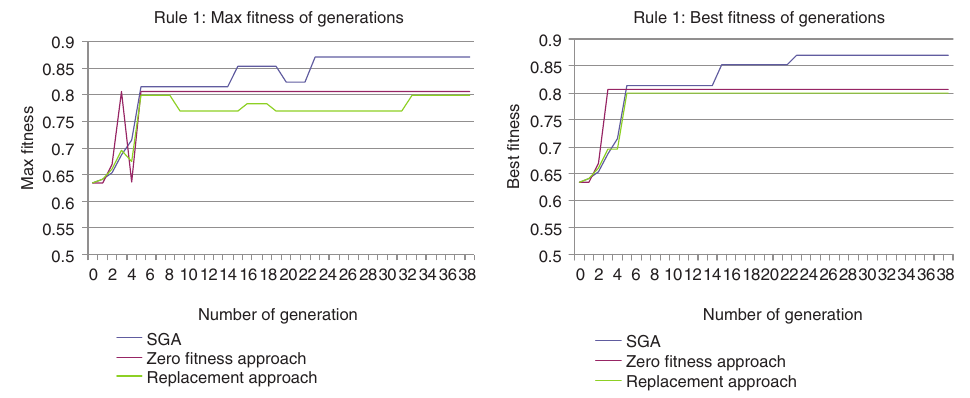
Figure 6 Analyses of maximum fitness of particular generation and global best fitness over number generation for rule 1.